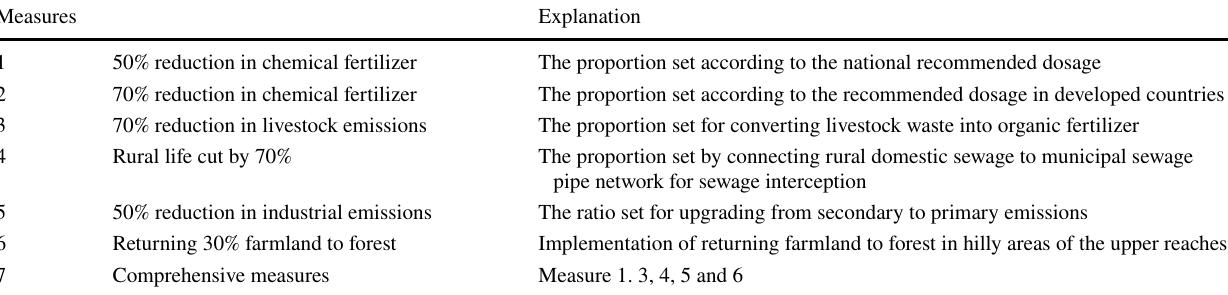
Table 4 Measures based on